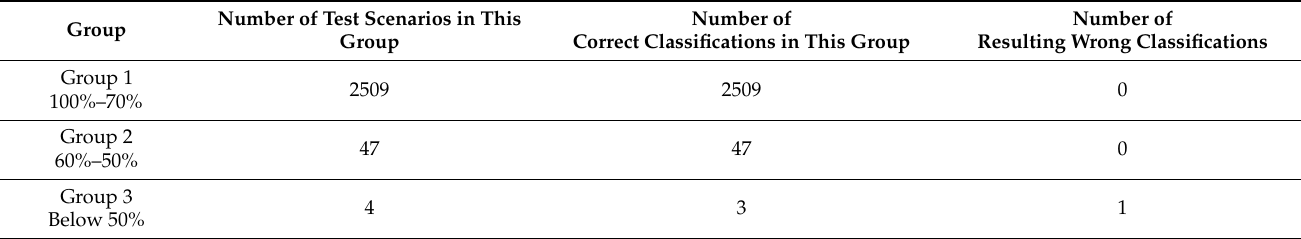
Table 8. Tabulation of the achieved agreement percentages amongst the decision trees in order to reach the final decision. Number of Test Scenarios in This Group